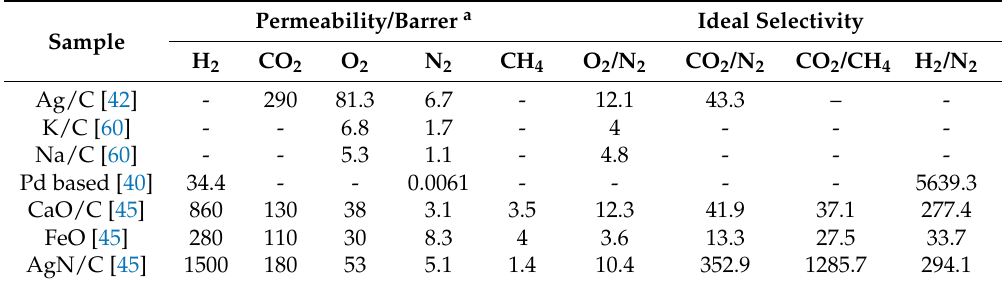
Table 1. Gas permeability and selectivity for some nanoparticle/C hybrid